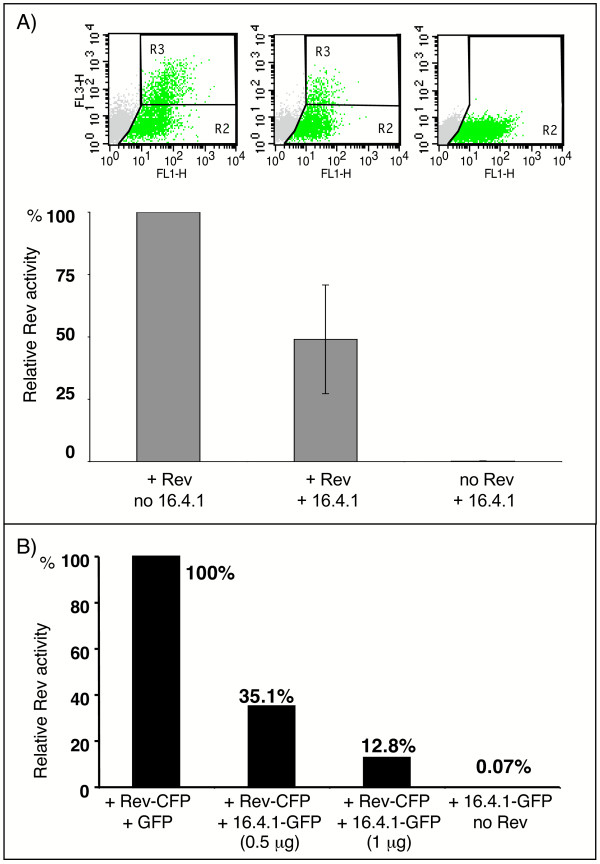
16.4.1 influences transactivation capacity of Rev in human cells. Panel (A) depicts the reduction of Rev activity obtained by cotransfection of 0.5 μg plasmids directing expression of 16.4.1 fusion proteins and 0.1 μg rev expression plasmids. The graph shows mean values and standard deviations of 5 independent experiments carried out in 293T cells expressing either IgG1-16.4.1 or 16.4.1-GFP in combination with Rev-GFP or Rev-CFP. FACS analysis was used to quantify the number of cells expressing the Rev-dependent RFP reporter encoded by pLRed(INS)2R (see Material and Methods) within the population of transfected cells. The dot plots above the bars (FL1 = green fluorescence, FL3 = red fluorescence) represent examples for evaluation of FACS data for fully functional Rev (left), inhibited Rev function by 16.4.1 coexpression (middle) and background expression of the reporter in the absence of Rev (right). The non-transfected, fluorescence negative 293T cell population is represented in grey and excluded from analyses. 293T cells containing the inactive reporter gene (no red fluorescence) and expressing GFP as transfection control were used to define the transfected cell population (R2, right dot plot). Cells transfected with all plasmids required for activation of reporter gene expression (expression plasmids encoding Rev, Tat and the reporter RFP) as well as for expression of the GFP transfection control contain a population of cells expressing both green and red fluorescent proteins defined as R3. The ratio of R3 to R2 represents the proportion of transfected cells showing Rev-dependent reporter expression (i.e. Rev activity). Rev activity in the absence of 16.4.1 was set at 100% (left bar of the graph). Coexpression of 16.4.1 fusion proteins diminished Rev activity to approximately 50% (middle bar). (B) The graph shows the result of a single experiment analysing the effect of different amounts of 16.4.1-GFP expression on Rev-CFP activity. Rev-CFP activity in the absence of 16.4.1-GFP was set at 100%. Coexpression of different amounts of 16.4.1-GFP reduced Rev activity to 35.1% (0.5 μg pC16.4.1sg143) or 12.8% (1 μg pC16.4.1sg143) demonstrating a dose dependent effect of the 16.4.1-GFP on Rev activity.